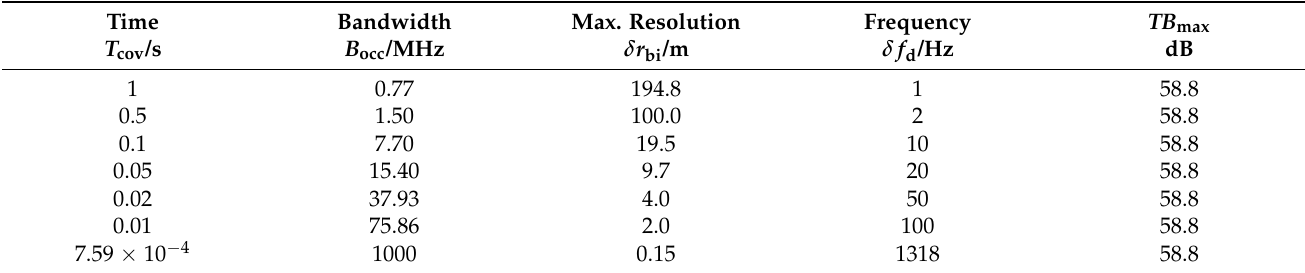
Table 1. Different sets before range walk, v eff = 700km/h, c = c em , f s ≈ B occ and TB max =